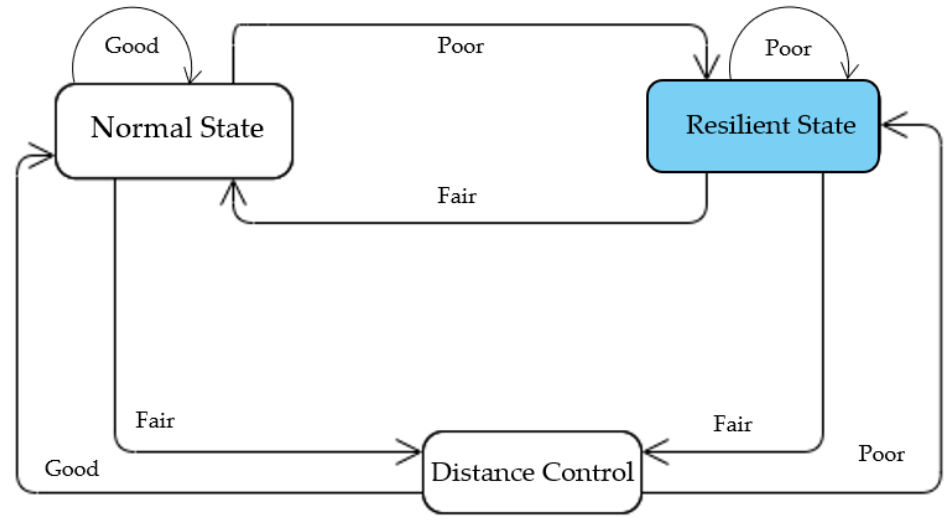
Figure 10. Abstract state model for communication failure.